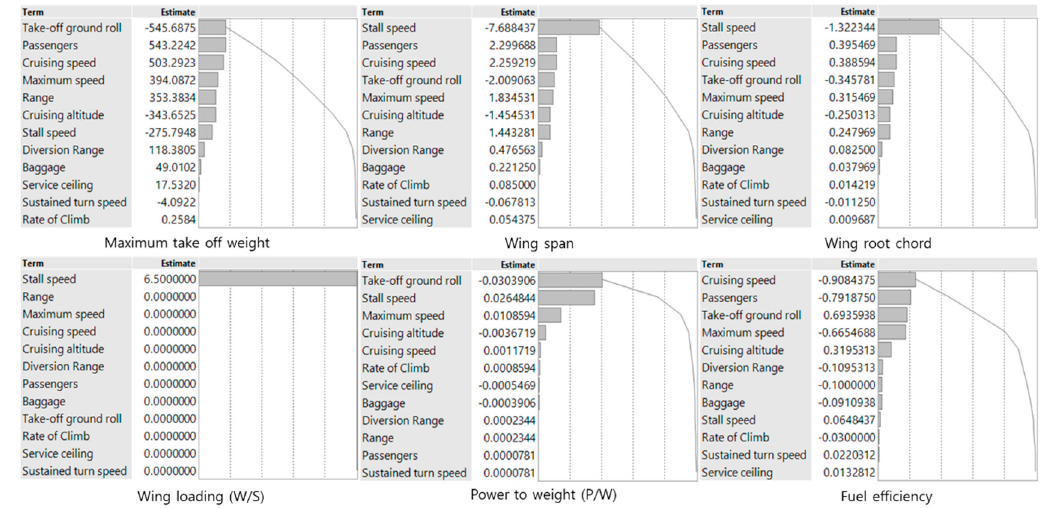
Figure 5. Pareto plot of design objective parameters.